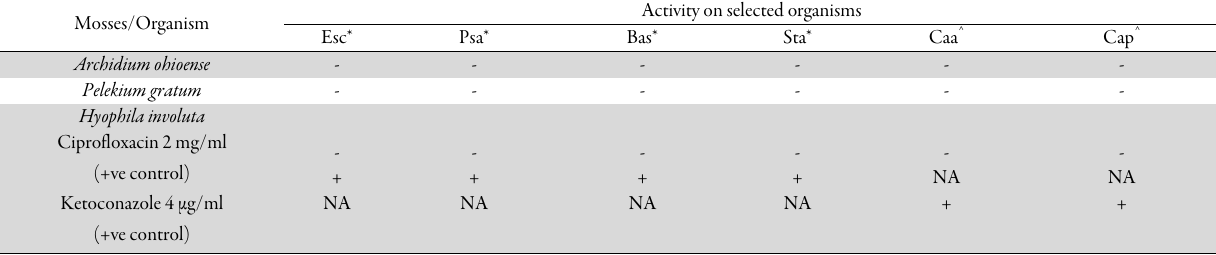
Table 2. Screening of antimicrobial activity of the ethanolic extracts of Archidium ohioense, Pelekium gratum, Hyophila involuta against different microoganisms